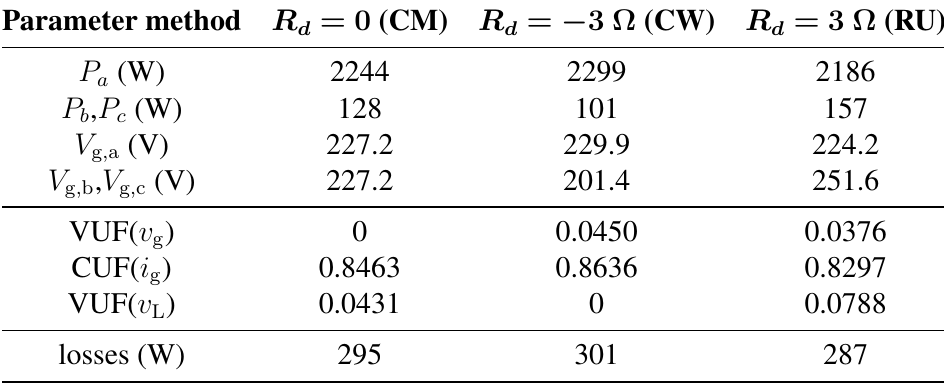
Table 3. One DG unit: CM (Conventional Method) versus RU versus the CW variant = 3 Ω and R = 0 Ω ). VUF, voltage unbalance factor; CUF, current unbalance ( R l v